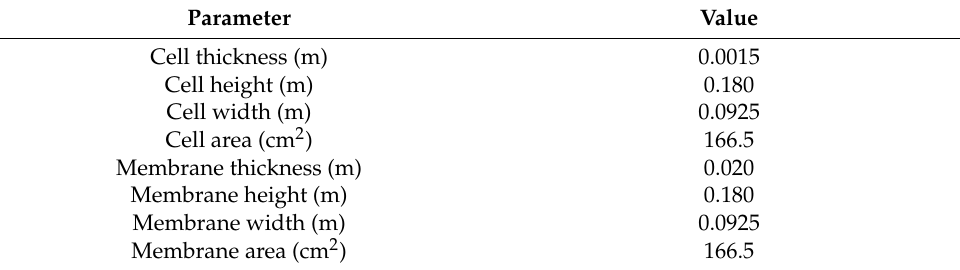
Table 1. Membrane design